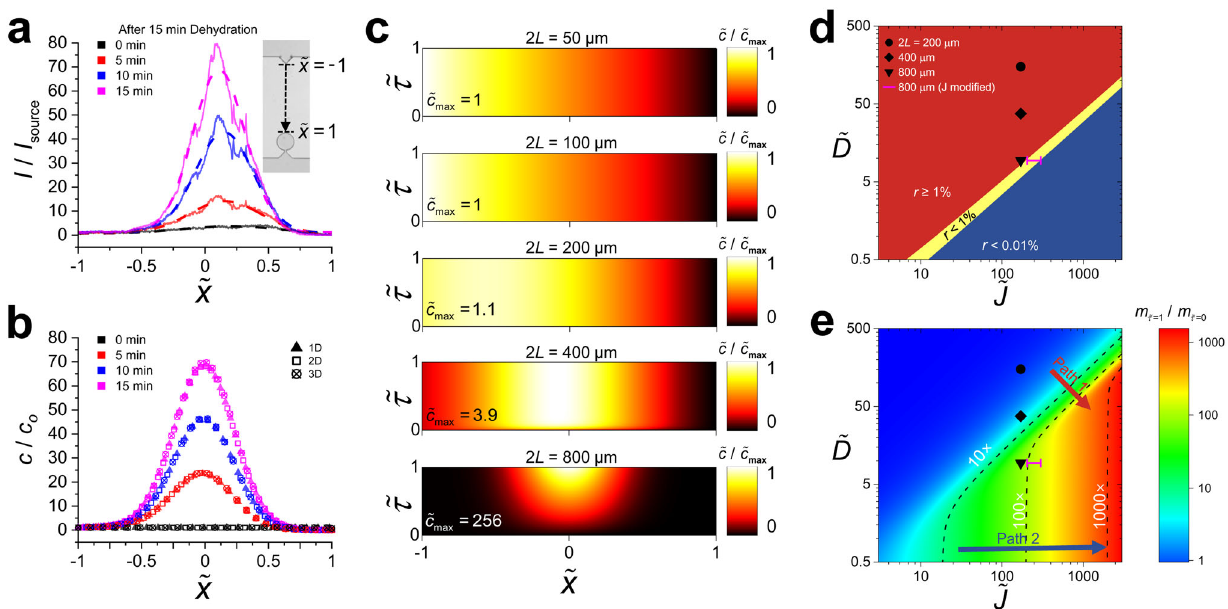
Fig. 3 Numerical simulation results validating diffusion- and advection-driven mass transport. a Experimental concentration distribution of the FITCs along the 800- µ m-long nanoslit. After 15 min of dehydration ( t = 0 min), the normalized FIs, I = I source are measured from the nanoslit for 15 min at 5-min intervals. b Numerical simulation results of the three different transient models (i.e., 1D, 2D, and 3D) under the same conditions as in the experiment in ( a ). c Transient numerical simulation results of the solute concentration distribution for the fi ve different nanoslit lengths (i.e., 2 L = 50, 100, 200, 400, and 800 μ m). The temporal solute concentration distribution along the nanoslit is normalized by the global maximum concentration calculated a t t = t o . d Two nondimensionalized parameters (i.e., ~ D and ~ J ) determine the reliability of the transport-control mechanism for small molecules. In other words, the nanoslit actively controls the mass transport of the solutes. e Total mass of the solutes concentrated inside the nanoslit (i.e., m ~ τ ¼ estimated by the two nondimensionalized parameters (i.e., ~ D and ~ J ). The contour lines separate the parametric conditions to achieve concentration factors of 10-, 100-, and 1000-fold,